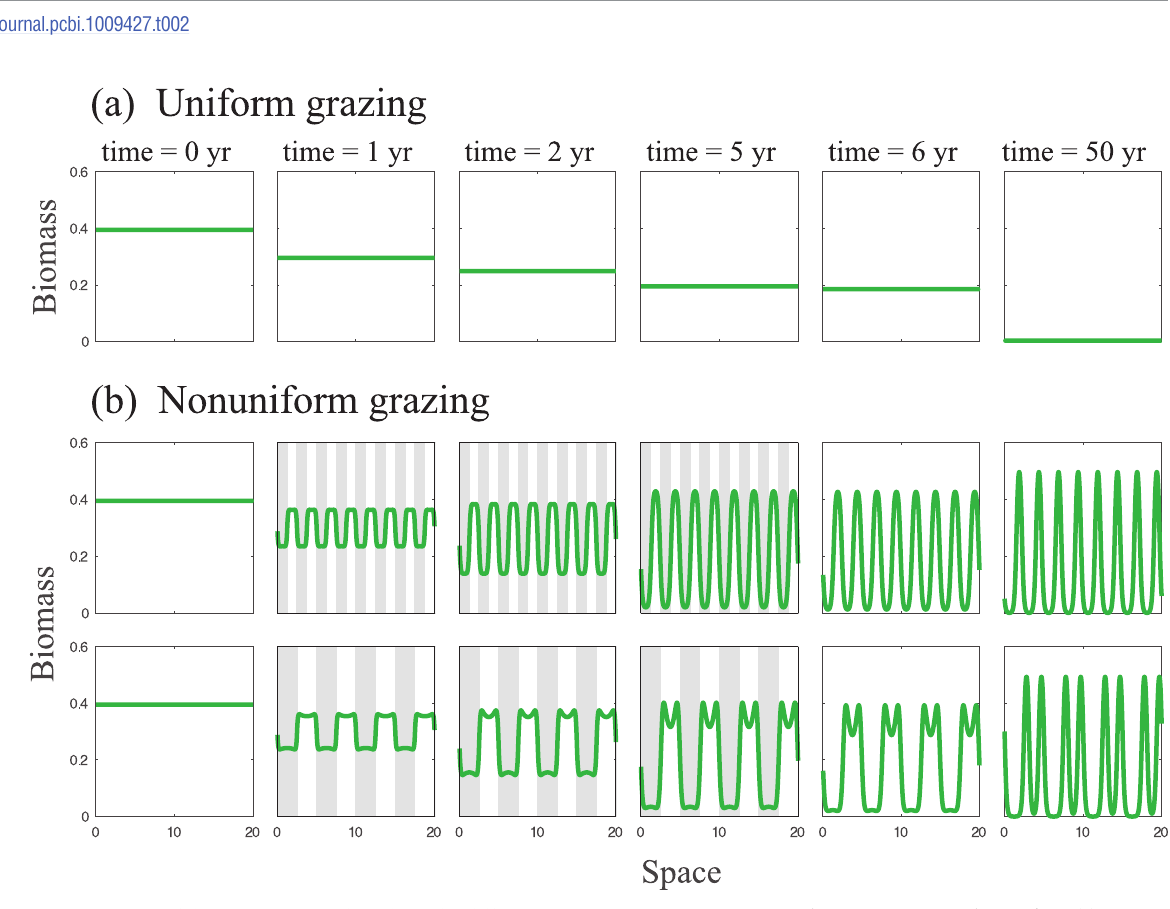
Fig 2. Response of the ecosystem to a drought under different grazing practices. Vegetation undergoes grazing in either uniform (a) or non- uniform (b) ways, modeled by modifying the biomass-decay parameter M in Eq (1). Snapshots taken over time (left to right) show the vegetation profiles, for a system undergoing a strong drought at t = 0, from precipitation P = 115 to P = 90[ mm / yr ] (similarly to red and green lines in Fig 1c). Uniform grazing is enacted by keeping a constant M = 2, while non-uniform grazing is modeled by having the system’s domain split into 16 (8) segments in the top (bottom) rows of panel b, where only odd segments undergo grazing for the first five years of a drought (marked by gray shading in the panels). During non-uniform grazing, values of M for grazed segments and non-grazed segments are M = 2.2 and M = 1.8,